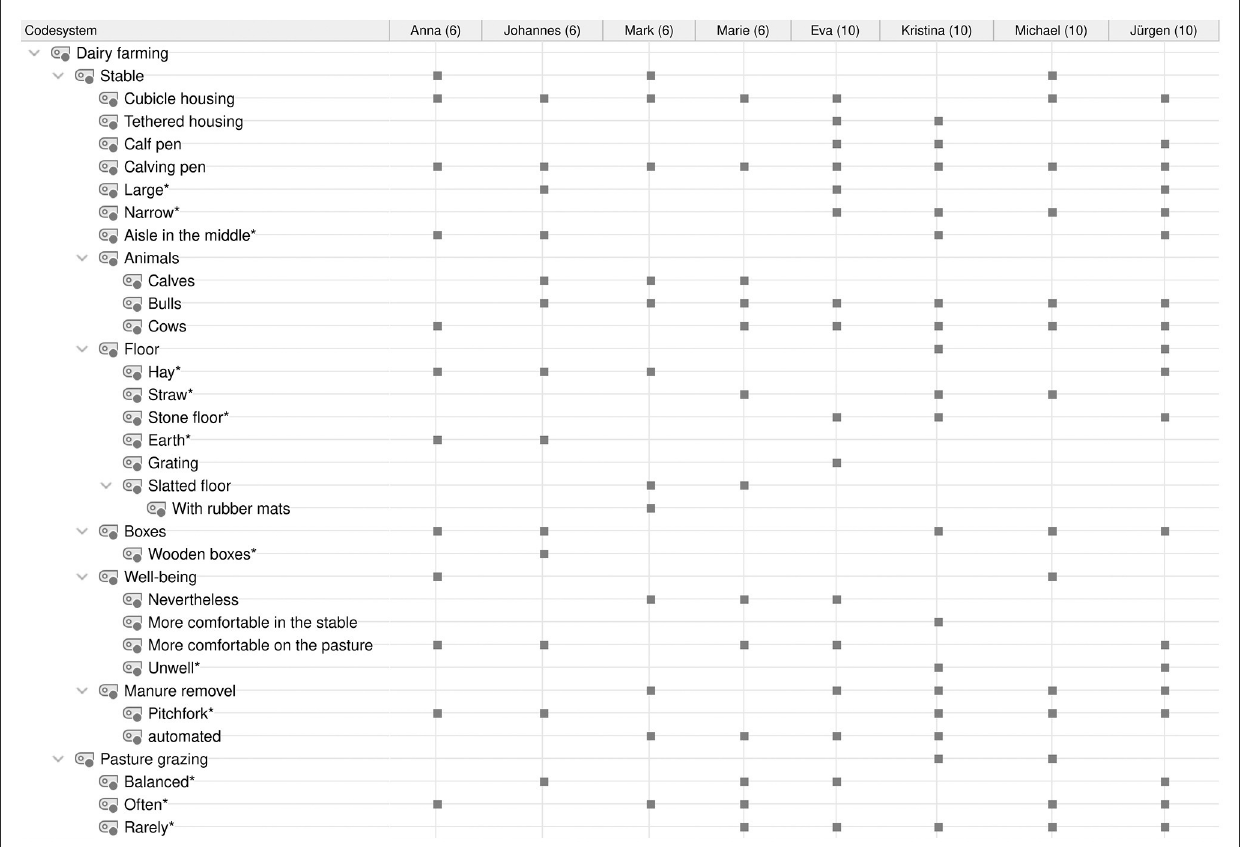
FIGURE5 Overview of the students’ statements on stable and pasture husbandry. * Inductively coded categories. The marks by the categories indicate that they were named by the